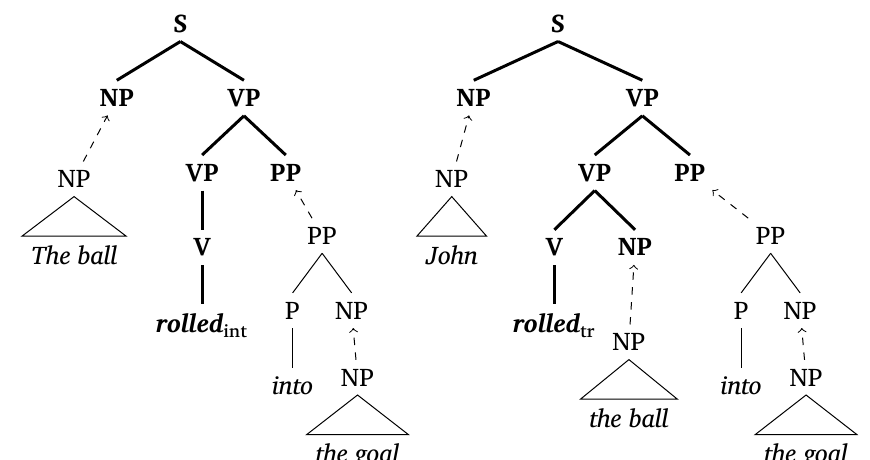
Figure 1: LTAG derivation for (1a) and (1b) with intransitive versus transitive rolled